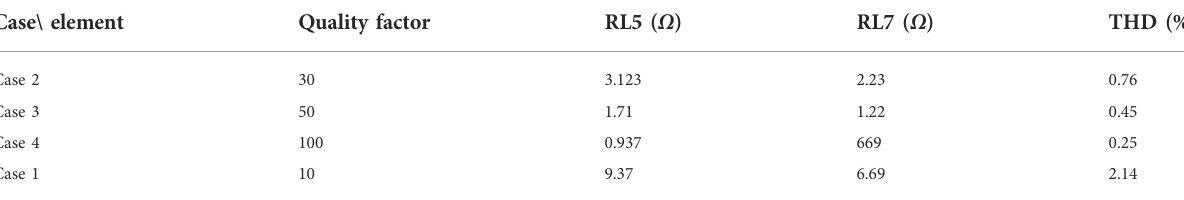
TABLE 3 After applying the priority method.